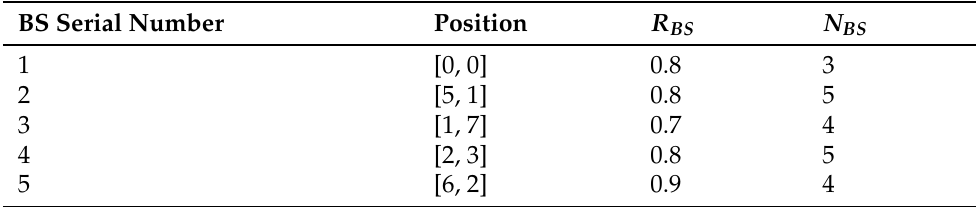
Table 5. Simulation setup for BSs with given user distribution.